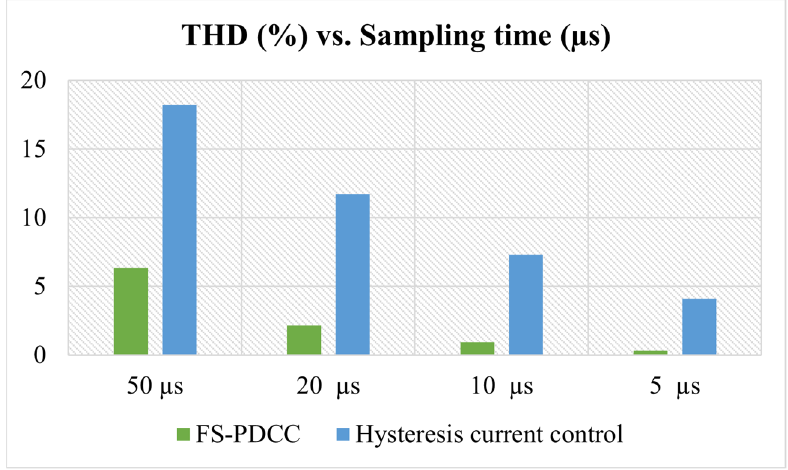
Figure 18. THD vs. sampling time comparison for FS-PDCC and hysteresis current control